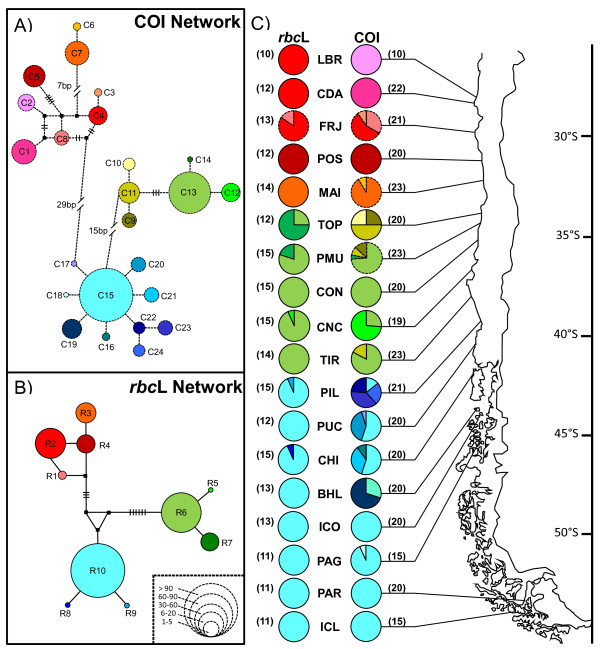
Phylogenetic relationships among haplotypes of M. laminarioides and their geographic distribution based on COI and rbcL.  Haplotype networks for the markers COI (A ) and rbcL (B), and pie charts showing the geographical distribution of haplotypes (C). In the networks, each circle represents a haplotype and its size is proportional to the frequency in which the haplotype was encountered in each population (correspondence between circle sizes and numbers of individuals is indicated in the box B). Black squares represent hypothetical un-sampled haplotypes. For haplotypes separated by more than one mutational step, the number of steps is indicated by black bars (for values < 7), or by a number of base pairs, bp (for values ≥ 7). Pie charts’ color-code corresponds to the one used in haplotype networks. Abbreviations for population codes are as in Table 1. Numbers of sequenced individuals are given between brackets. See Additional files 1 and 3 for details.